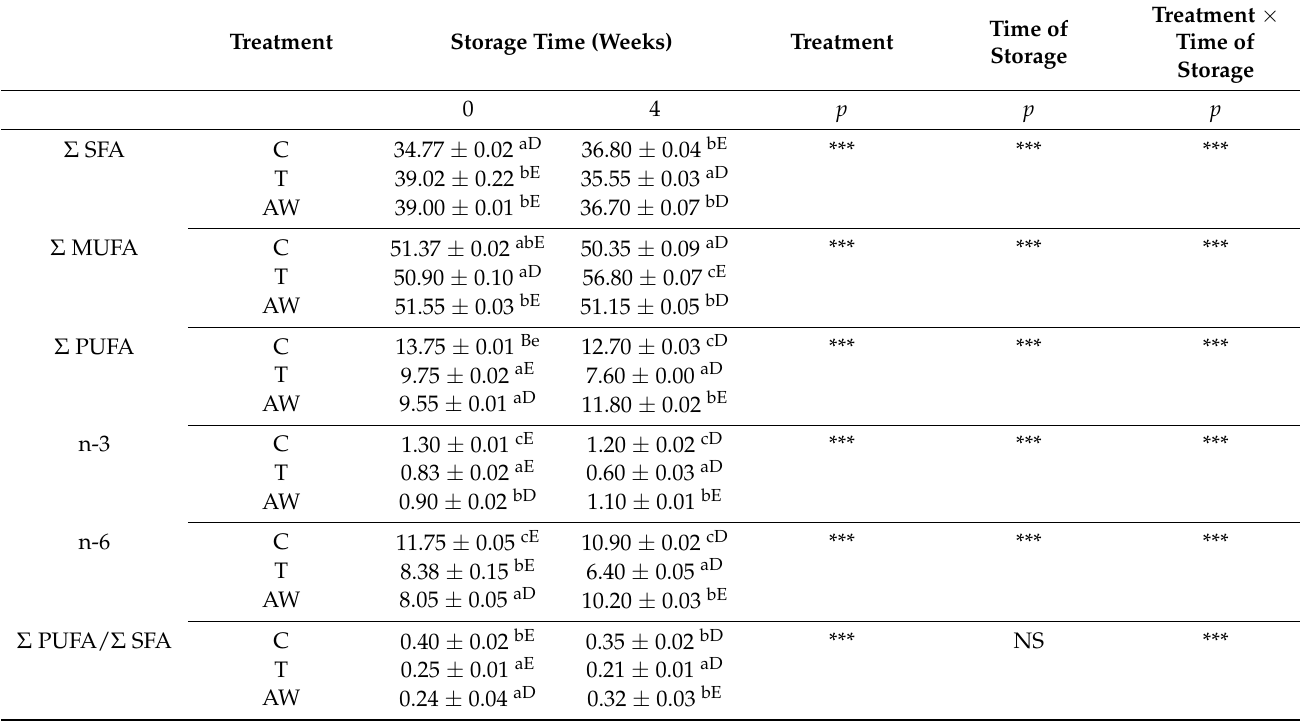
Table 5. Fatty acid composition (% total fatty acids) in experimental pork bacon after fermentation and four weeks of cold